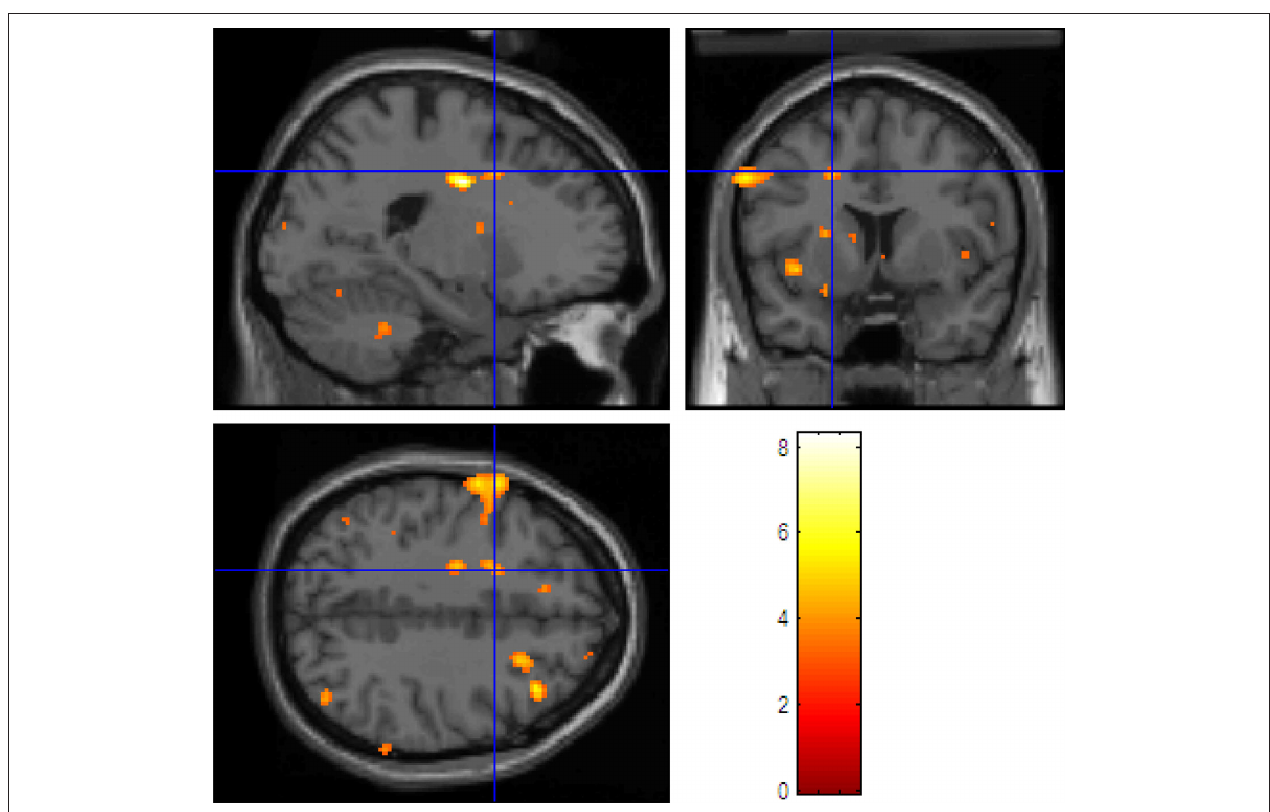
Figure 1 | An example fMri scan showing brain